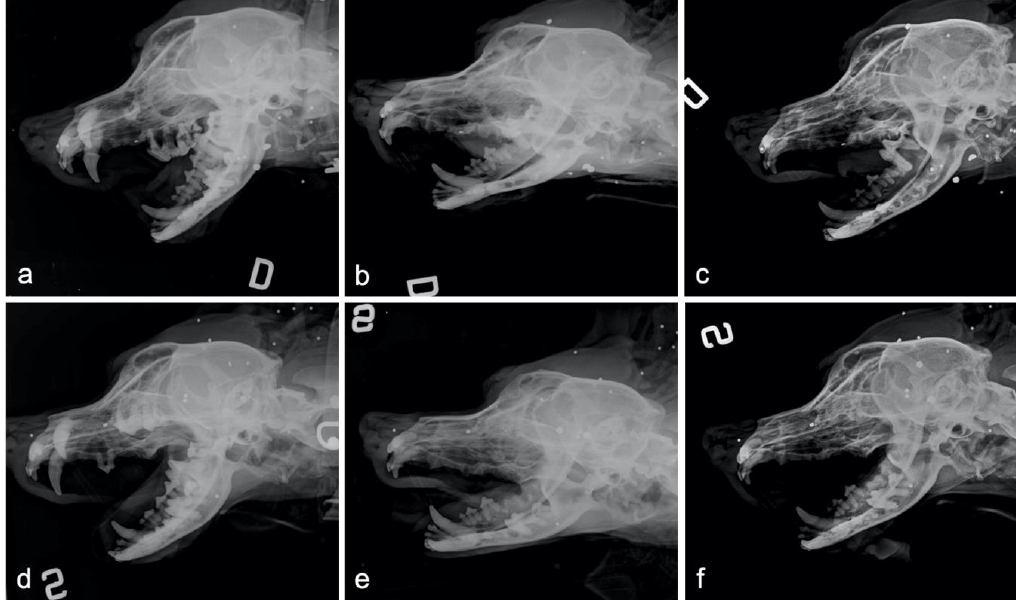
Figure 5. Time point radiographic sequence of both sides during the split mouth study. The first column ( a , d ) shows the preoperative radiographic aspect at recruitment. The second column ( b , e ) shows the radiographic aspect of the immediate postoperative time (T0). The third column ( c , f ) shows the radiographic aspect after three-week follow-up (T1). The first line ( a – c ) shows the oblique radiographs obtained for the dog in the right lateral recumbency (D indicates the right lateral recumbency), left maxillary hemi-arch, and the right mandibular hemi-arch are visible inside. The second line ( d – f ) shows the oblique radiographs obtained for the dog in the left lateral recumbency (S indicates the left lateral recumbency), right maxillary hemi-arch, and left mandibular hemi-arch are visible